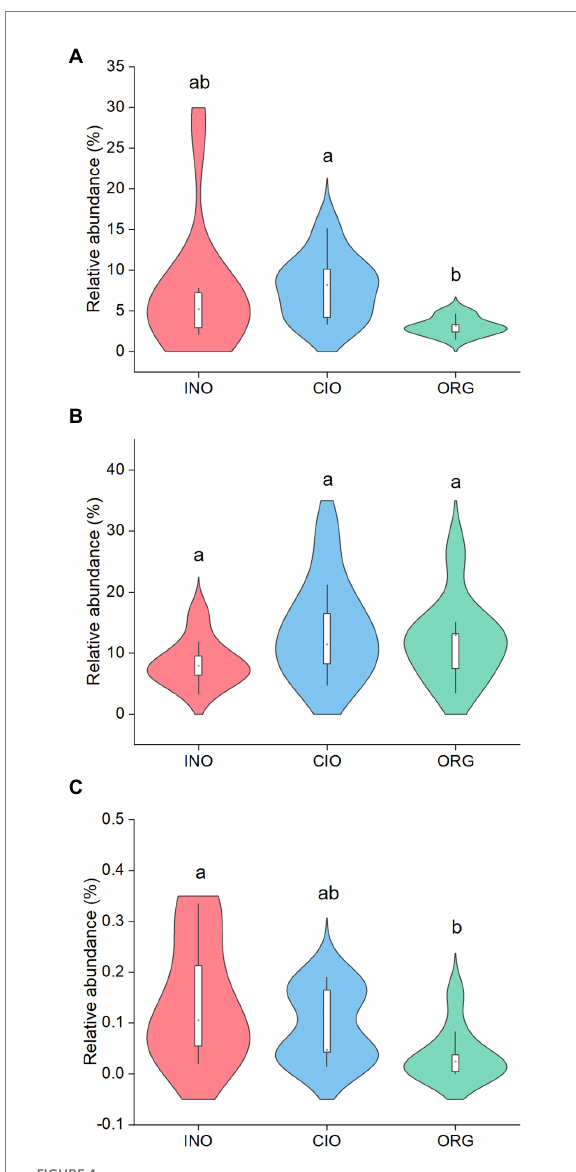
FIGURE 4 Relative abundance of pathogenic fungi (A) , saprotrophic fungi (B) , and arbuscular mycorrhizal fungi (C) under three soil N regimes. INO, inorganic N-dominated; CIO, co-dominated by inorganic and organic N; ORG, organic N-dominated. Different lowcase letters indicate significant differences at p <